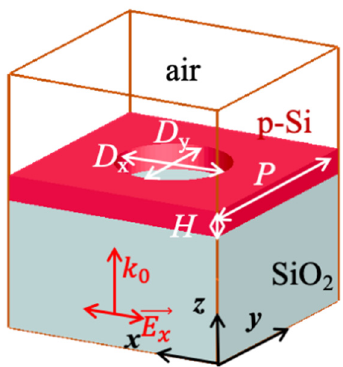
Figure 1. Schematic of silicon nanoholes on a silica substrate with diameters D x, D y, thickness H , and lattice period P . The illumination is injected into the nanohole from the bottom.